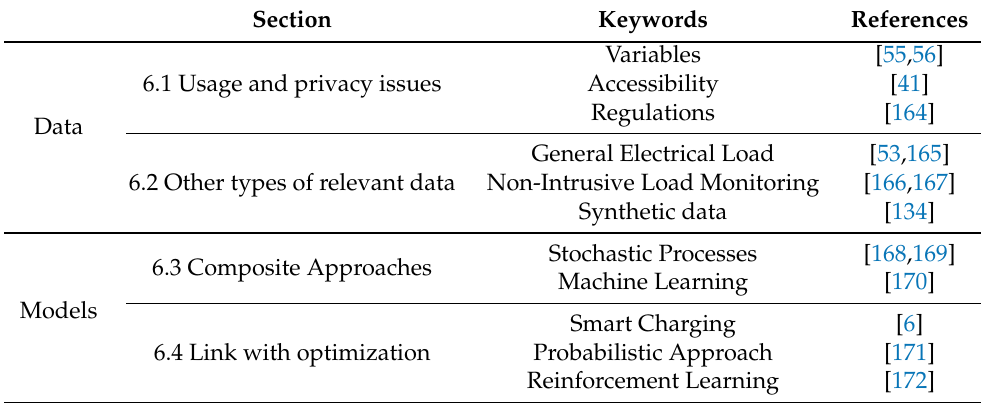
Table 7. Gaps and future work for EV load data and models. Sections 6.1 and 6.2 deal with data prospects and limitations while Sections 6.3 and 6.4 describe new ways of modelling and tie EV load models to optimization of charging